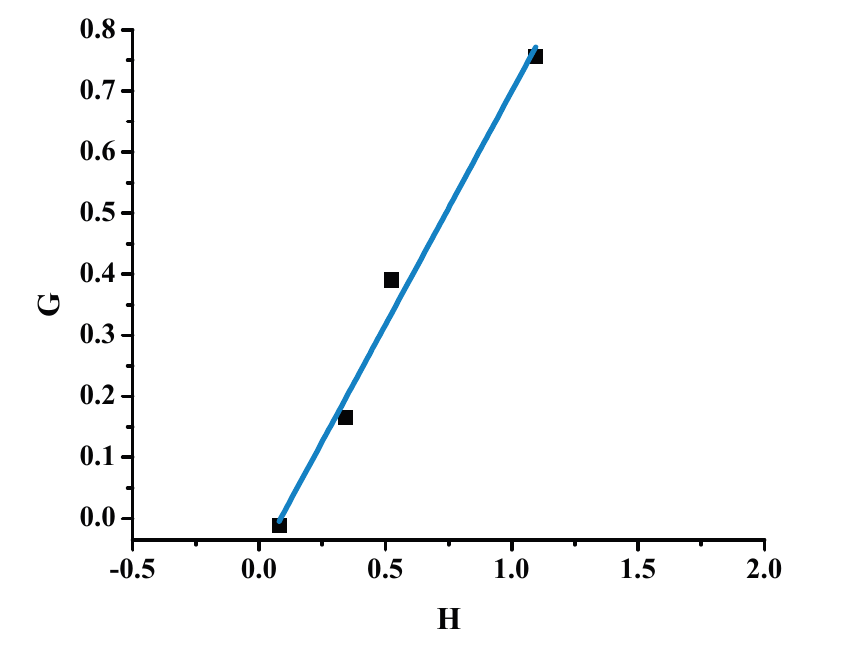
Figure 1. FR plot of the statistical copolymers. Table 3. Reactivity